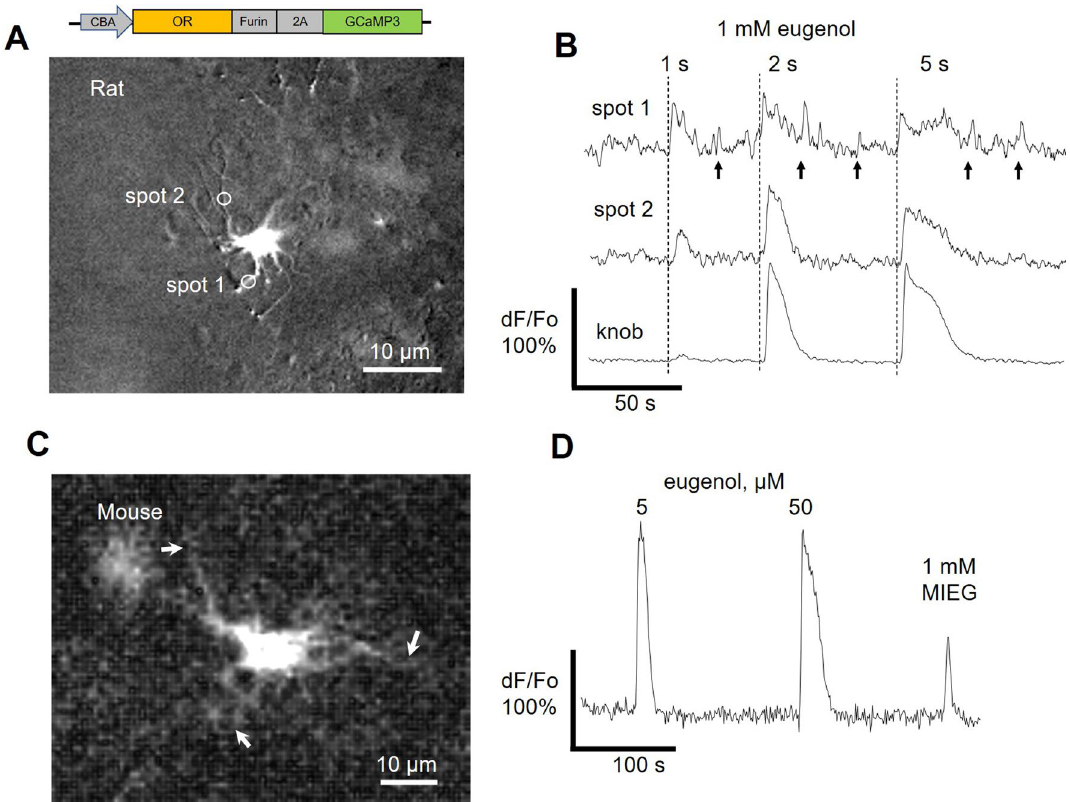
Figure 2. Robust eugenol-evoked activation of mammalian OSNs ectopically expressing Olfr73. Neuronal activity was measured with GCaMP3 expressed from the same rAAV2/5 vector along with the OR. ( A , B ) A single knob of the rat Olfr73-OSN which was stimulated with a solution containing 1 mM eugenol with pulses of increasing duration. A short 1-s long pulse activated nearly threshold response in the knob (bottom trace). However, in two representative cilia the same stimulus elicited much stronger relative increase of GCaMP3 fluorescence (spot 1 and 2). Note, activity persisted as reflected by a transient intraciliary Ca 2+ fluctuations (arrows, upper trace). ( C , D ) Mouse Olfr73-OSN was strongly activated by a low concentration of eugenol (5 µM, 5-s pulse). Application of methylisoeugenol (MIEG, 1 mM, 5-s pulse) also elicited a response. Cilia attached to the knob can be clearly resolved